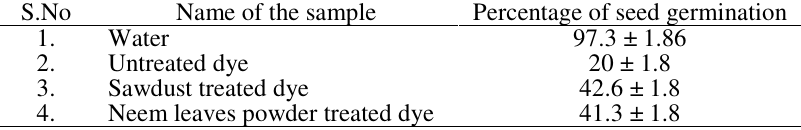
Table 3. The effect of pH on percentage of seed germination of Vigna mungo L.